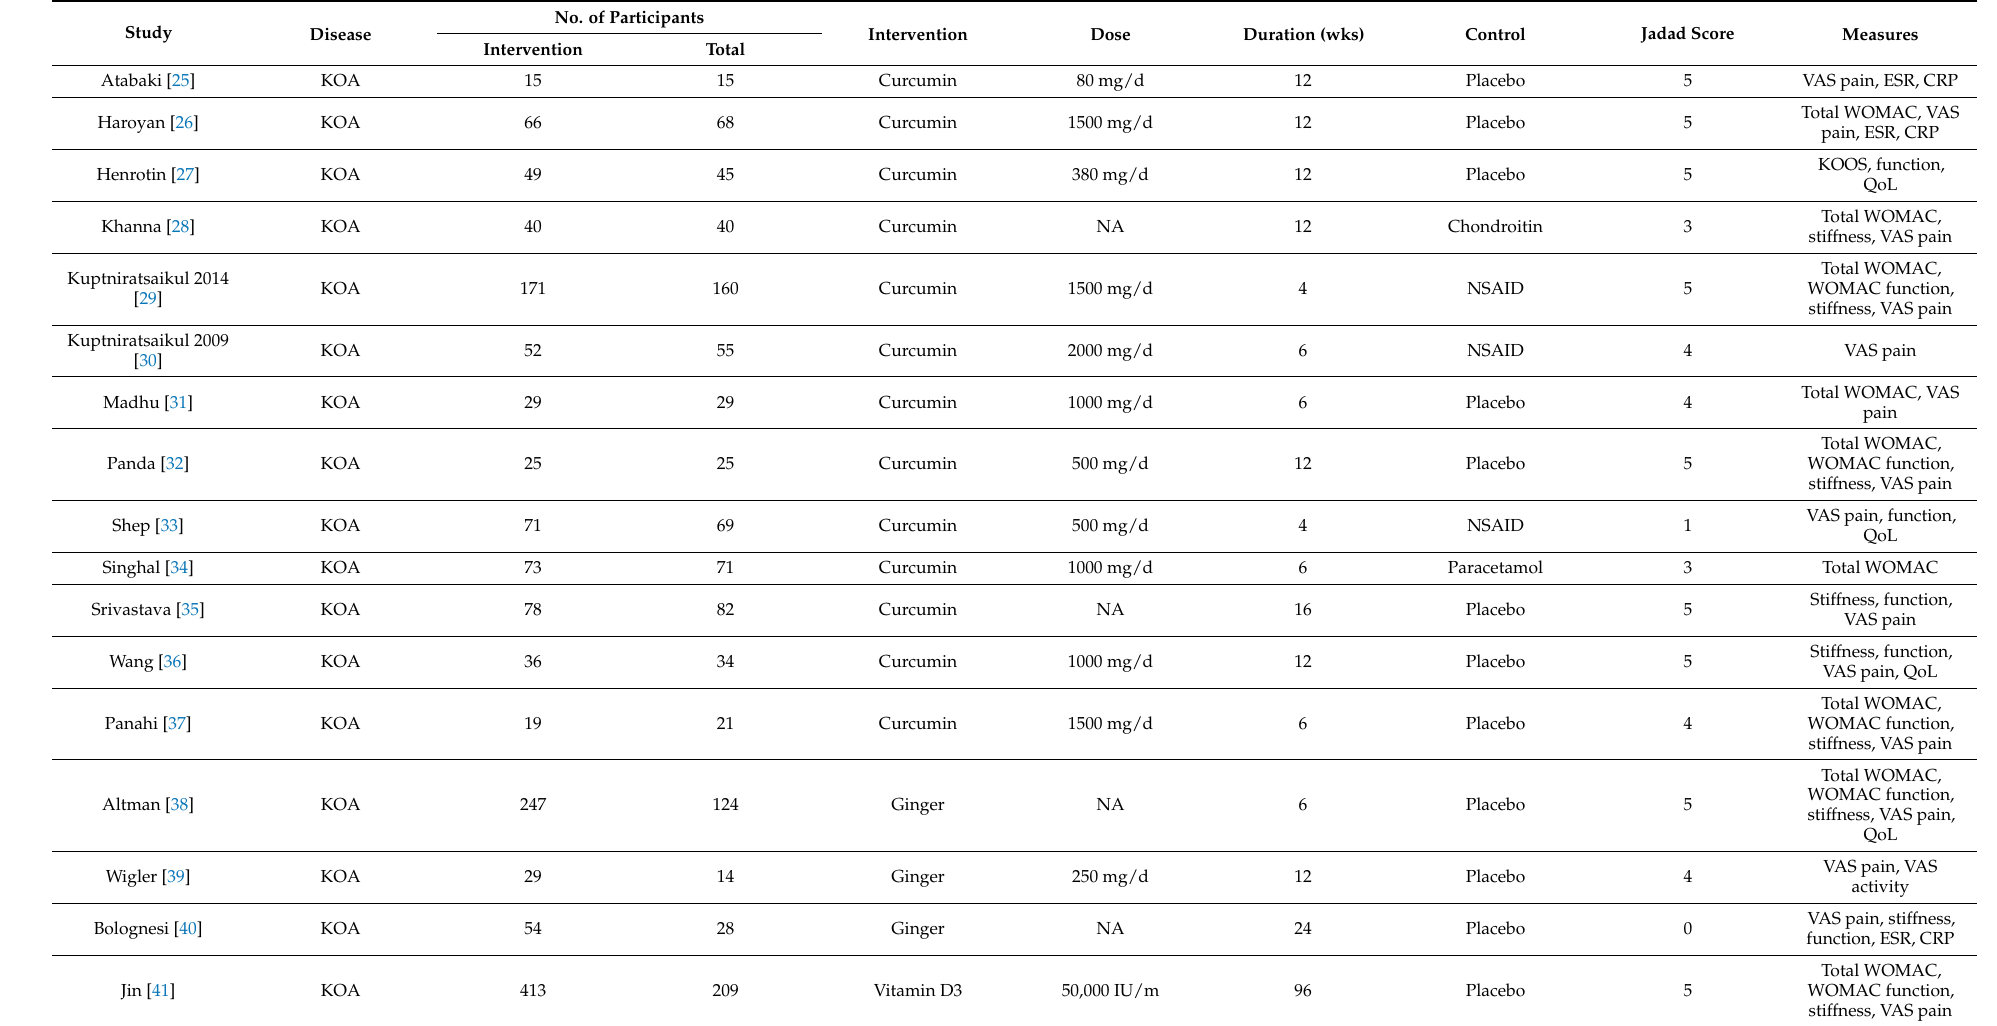
Table 1. Characteristics of the publications included in the